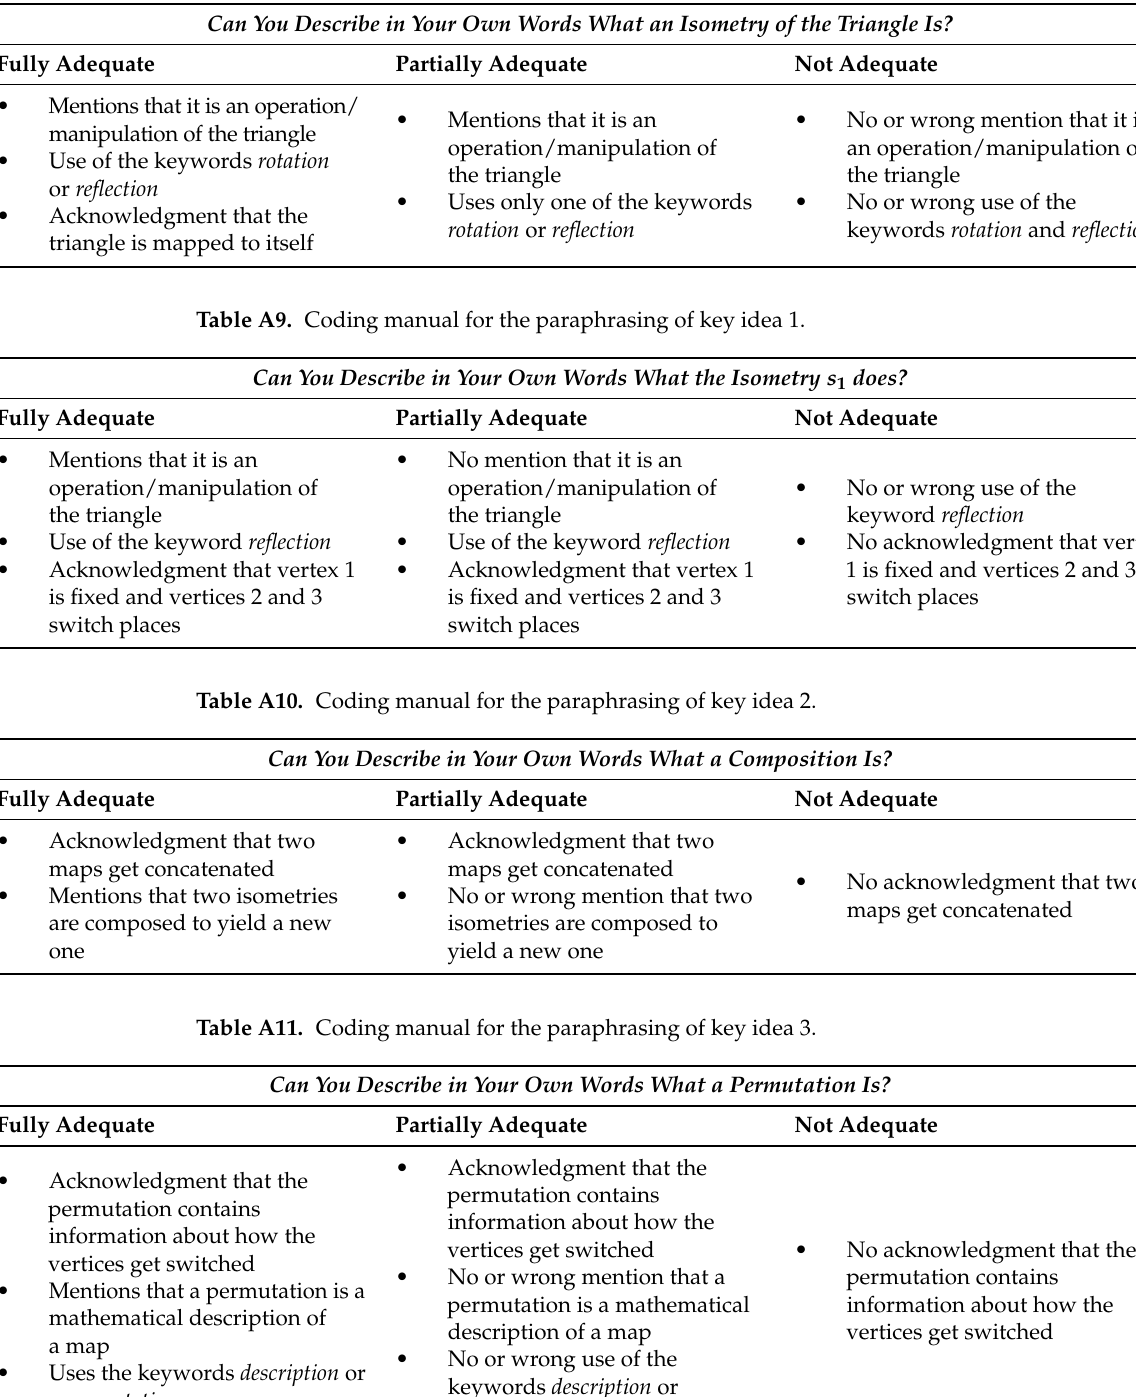
Table A8. Coding manual for the paraphrasing of key idea 1.